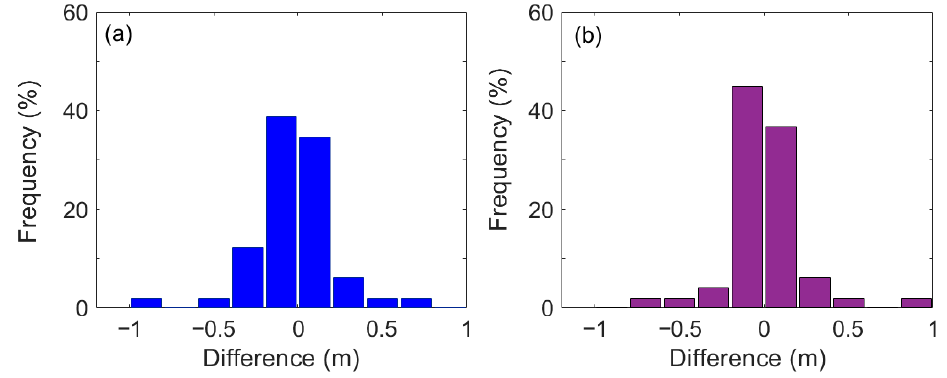
Figure 7. Validation of WSE obtained by configuration B against CryoSat-2 observations. ( a ) and ( b ) The distribution of differences between simulated and satellite WSE from 2016–2018 using uniform and variable roughness parameters, respectively.